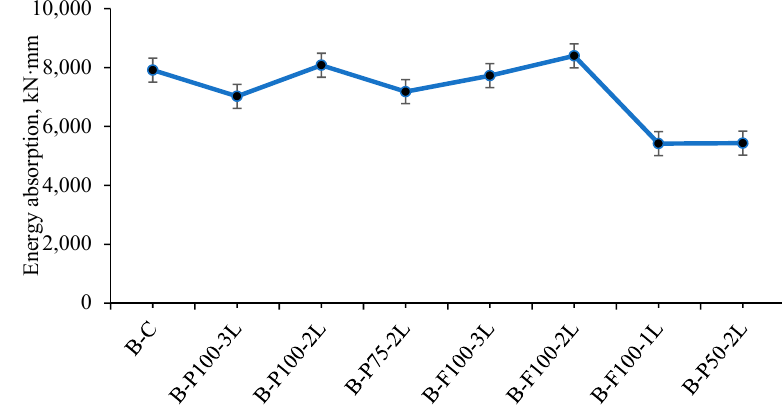
Figure 11. The value of energy absorption (EA) capacity for all